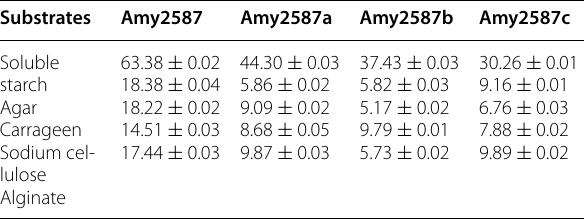
Table 1 Specific activity levels (U/mg) of Amy2587 and three truncated Amy2587 variants with different